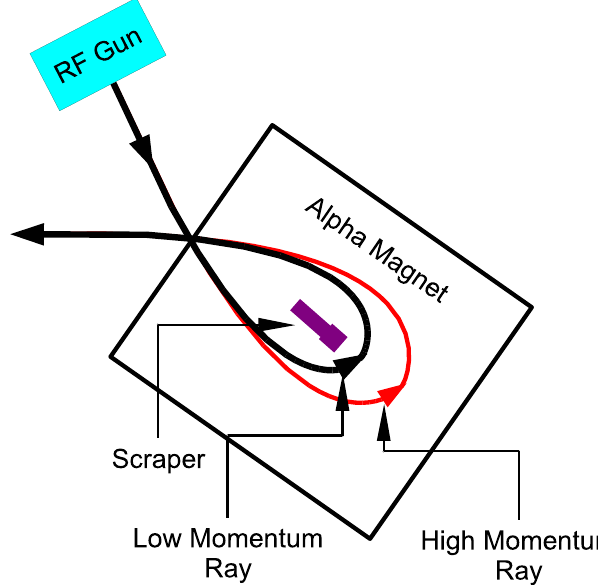
FIG. 2. (Color) Schematic of the APS linac rf gun/alpha magnet system showing that beams of different momenta take different paths through the alpha